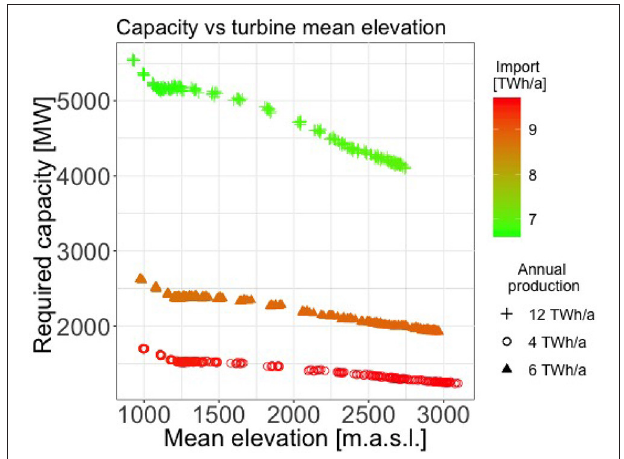
FIGURE 10 | The required capacity as function of the mean elevation of the locations where turbines are located in each scenario, with scenarios for the 3 production targets of 4, 6, and 12 TWh/a.